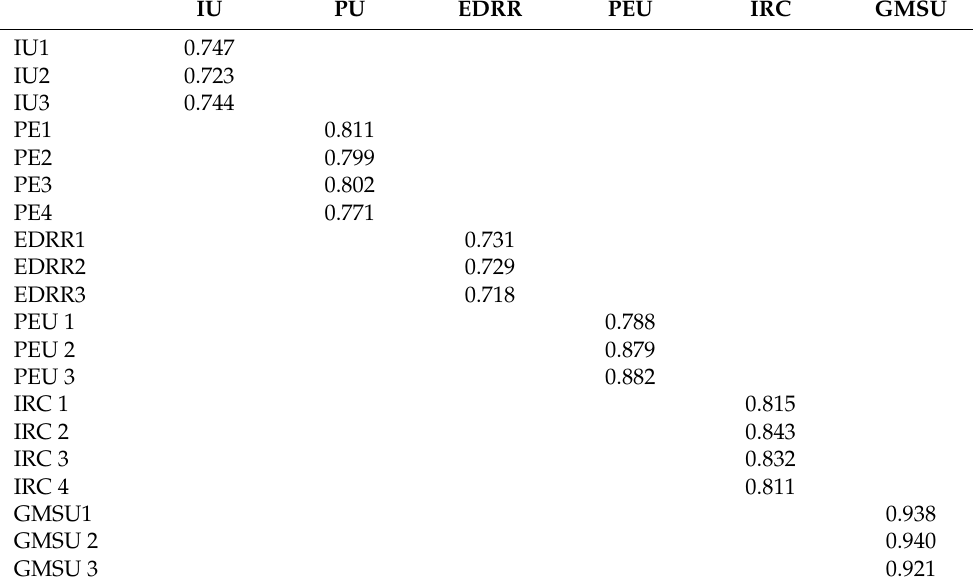
Table 5. Correlation matrix of reflective/latent variables.